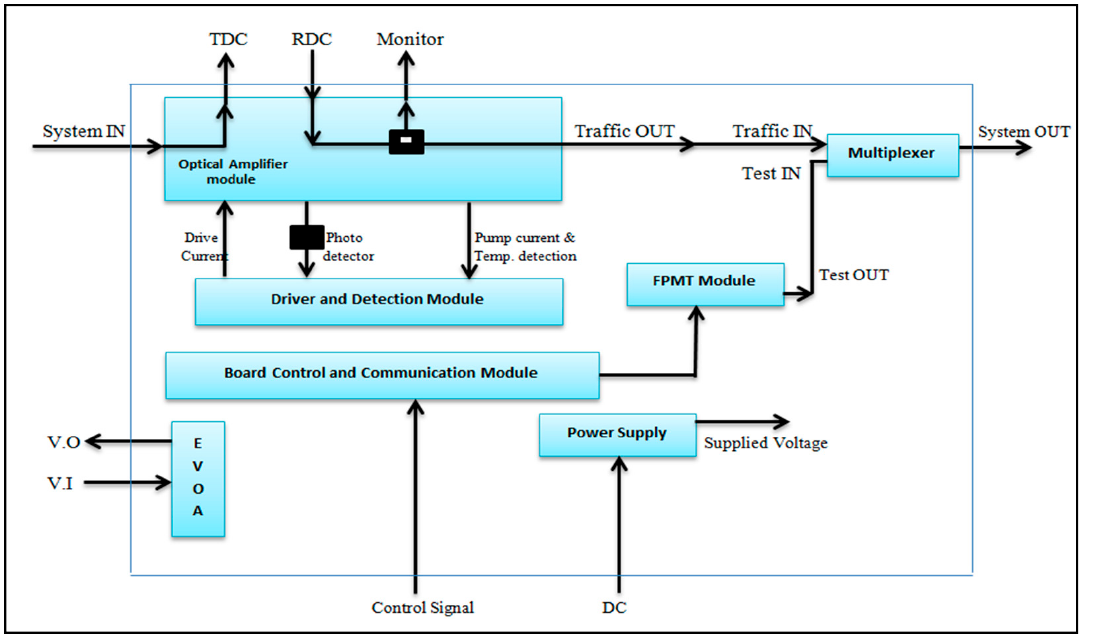
Figure 4. The optical amplifier board block diagram used in the transmit side of the DWDM system structure after adding the FPMT detection circuit.